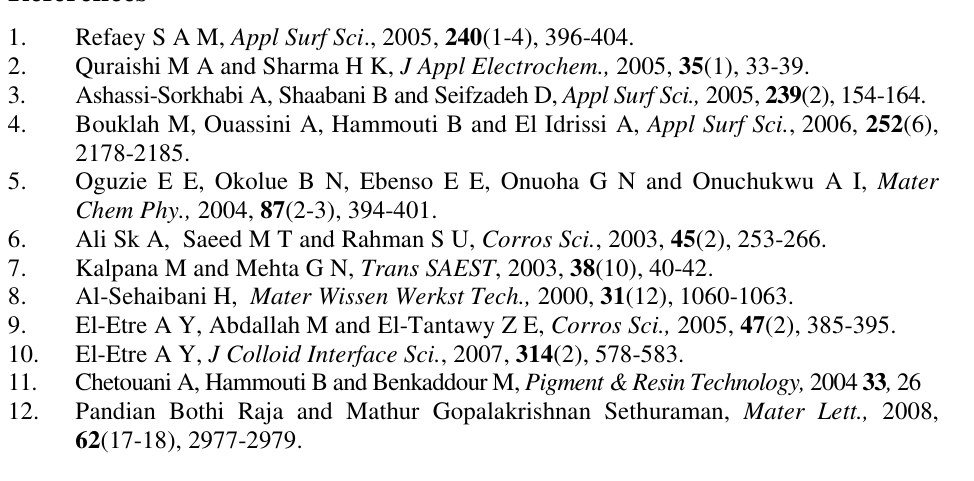
SO with and without plant extract 2 4